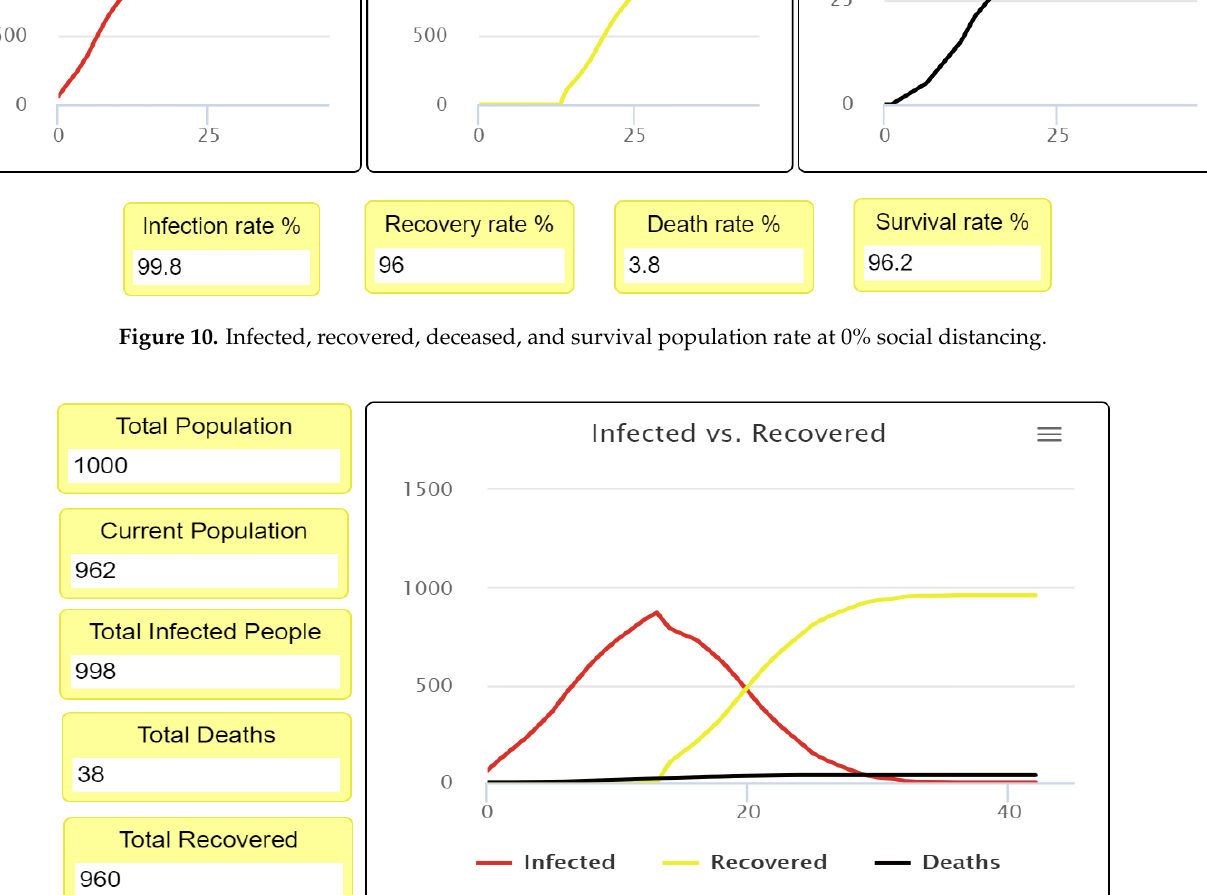
Figure 11. Infected versus the recovered people curve, when the fatality rate is 3% with 0% social distancing.